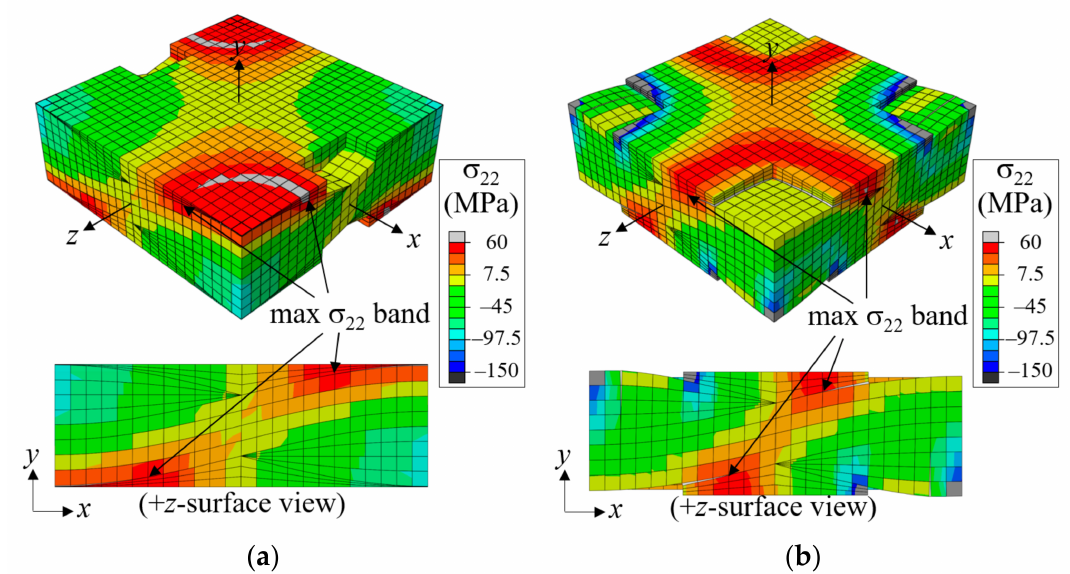
Figure 19. Comparison of σ 22 distribution for symmetric unit cells at ˆ ε xx = 0.008; ( a ) MPV2; and ( b ) MPV4. (Deformation scale factor = 2).